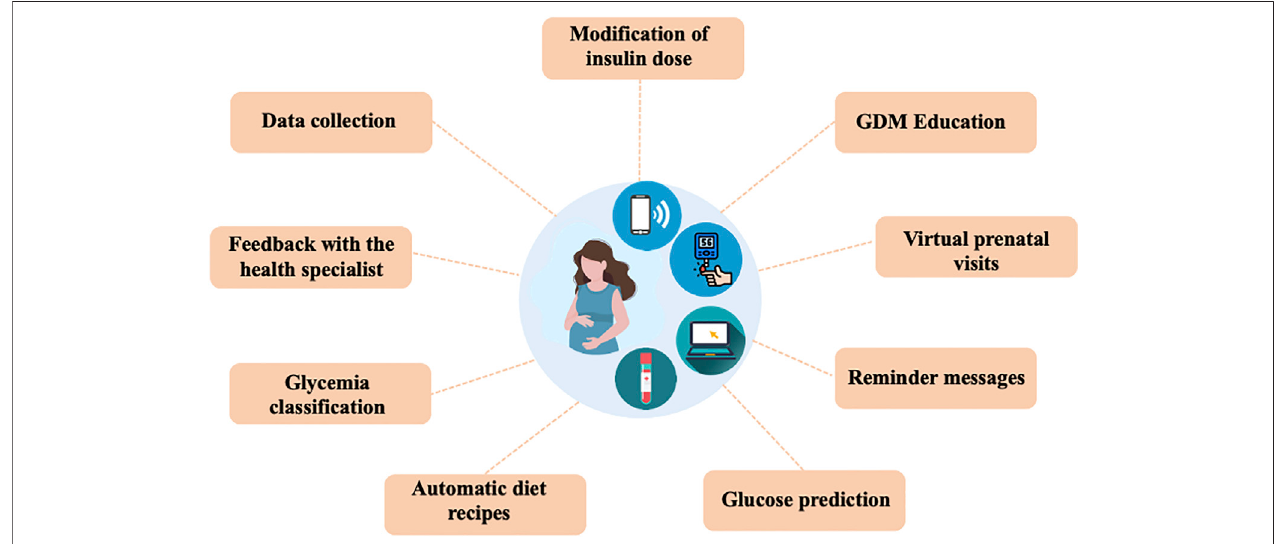
FIGURE 3 | The technological applications were mainly focused on the objective of improving glycemic control and supporting pregnant women in understanding GDM. Nine functions were selected that were common in the applied technologies.